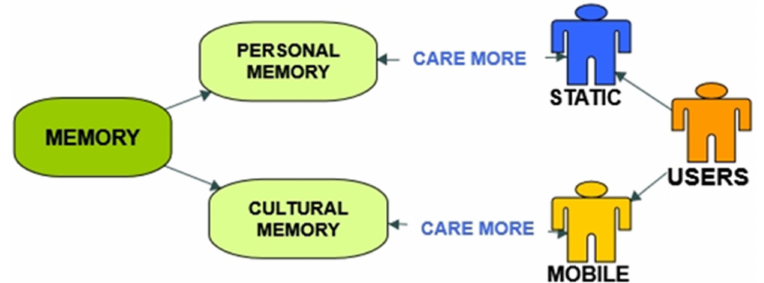
Figure 6. Users’ connections to memory and place experience diagram executed using Nvivo12. Source: F.